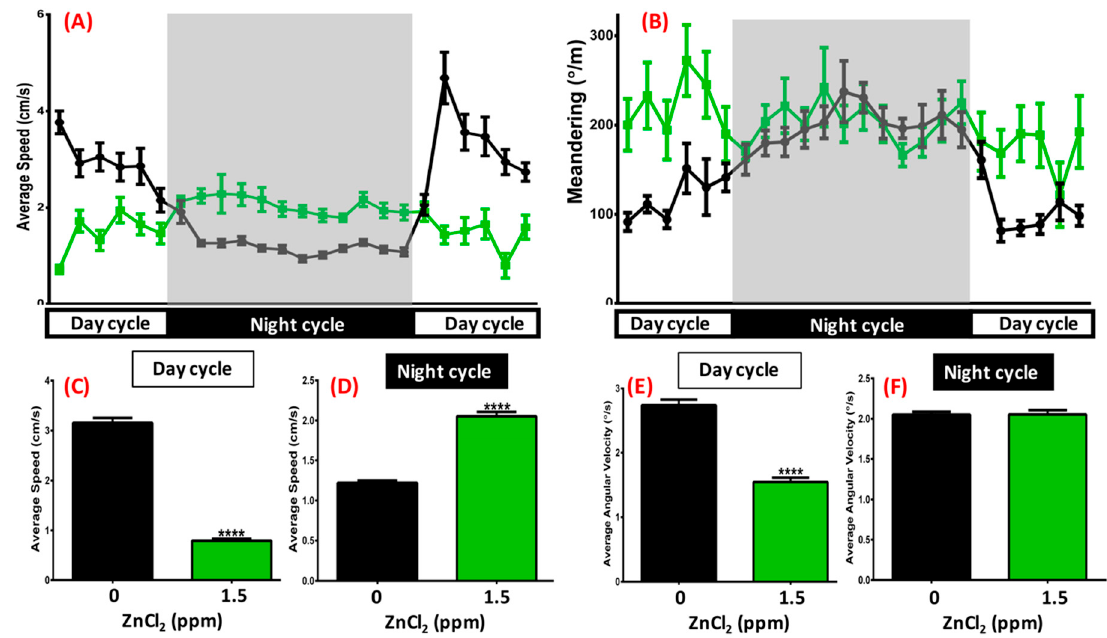
Figure 6. Circadian rhythm test after 21-day exposure. ( A ) Average speed and ( B ) meandering of 1.5 ppm ZnCl 2 -treated (green line) and control fish (black line) during day/night cycle. The gray area shows the dark period and the unshaded area shows the light period. Eighteen fish were observed for both the control and ZnCl 2 -treated groups. Quantitative comparison of average speed during ( C ) day cycle and ( D ) night cycle. Quantitative comparison of average angular velocity during ( E ) day cycle and ( F ) night cycle. Data are presented as means ± SEM (**** p ≤ 0.0001).